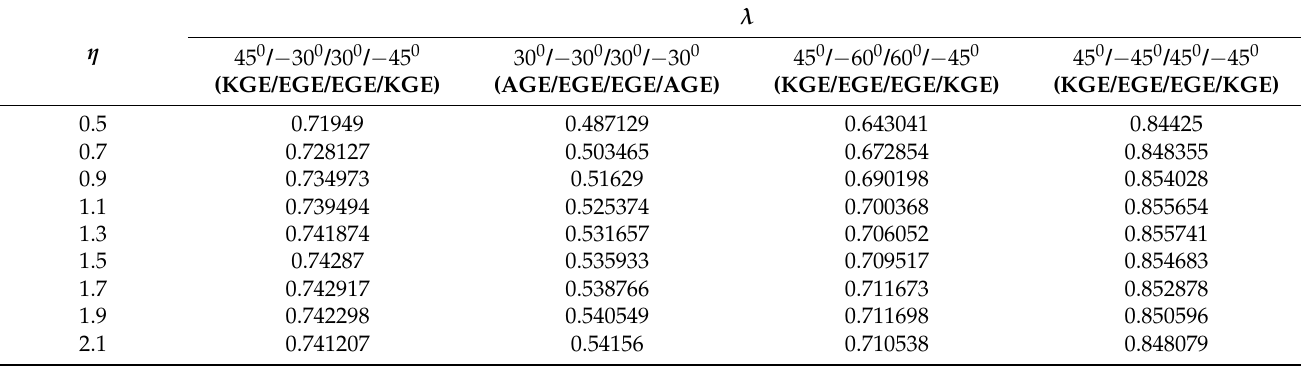
Table 5. Relation of linear thickness variation η and the fundamental frequency parameter λ . n = 2, γ = 0.05 and β =